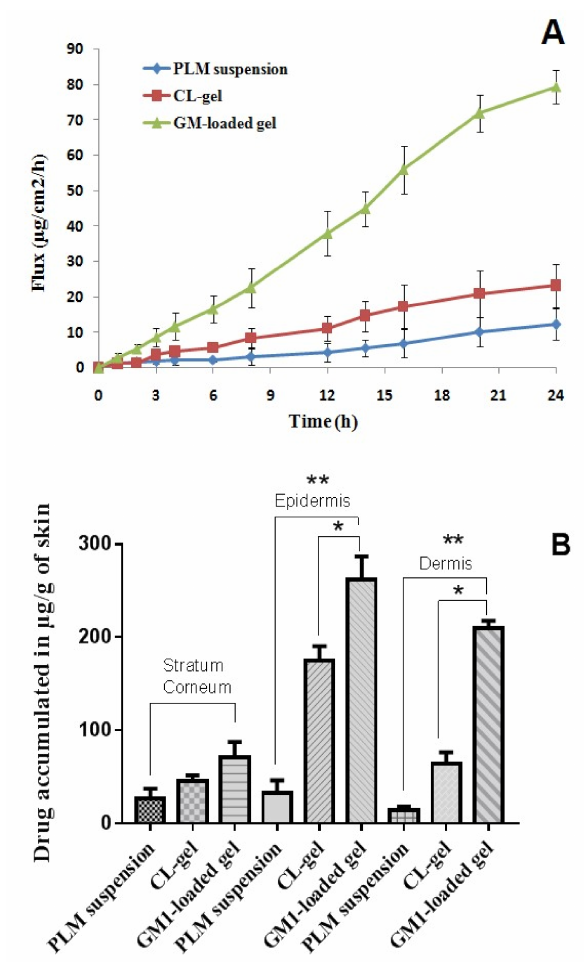
Figure 5. ( A ) Represents skin permeation studies in which flux of PLM suspension, CL gel and GM-loaded gel were compared and ( B ) The amount of drug retained in stratum corneum, epidermis and dermis from free PLM, CL gel, and GM-loaded gel, respectively. Data expressed as mean ± SD ( n = 3) (* p ≤ 0.05, ** p ≤